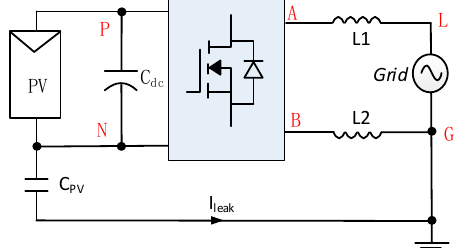
Figure 1. Topologies of ( a ) half-bridge inverter; and ( b ) full-bridge inverter (named H4).